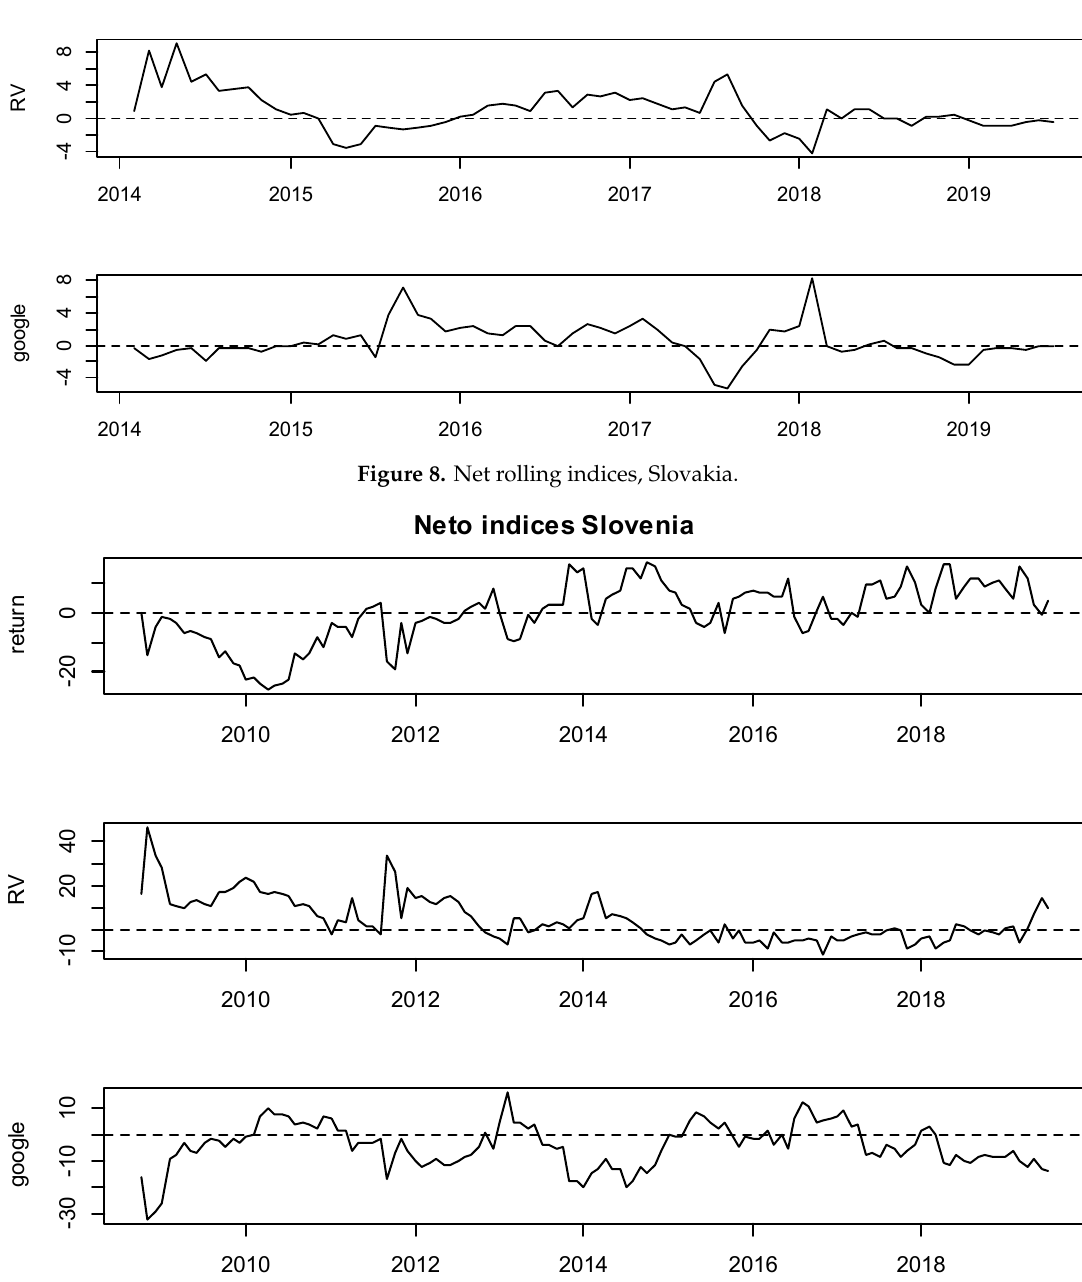
Figure 9. Net rolling indices, Slovenia.